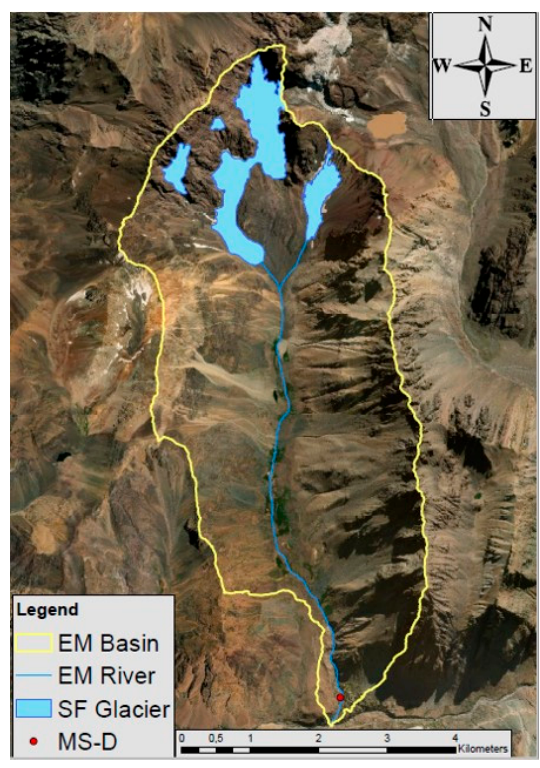
Figure 1. The Estero Morales (EM) basin and San Francisco Glacier (SF) with the location of monitoring station MS-D. station